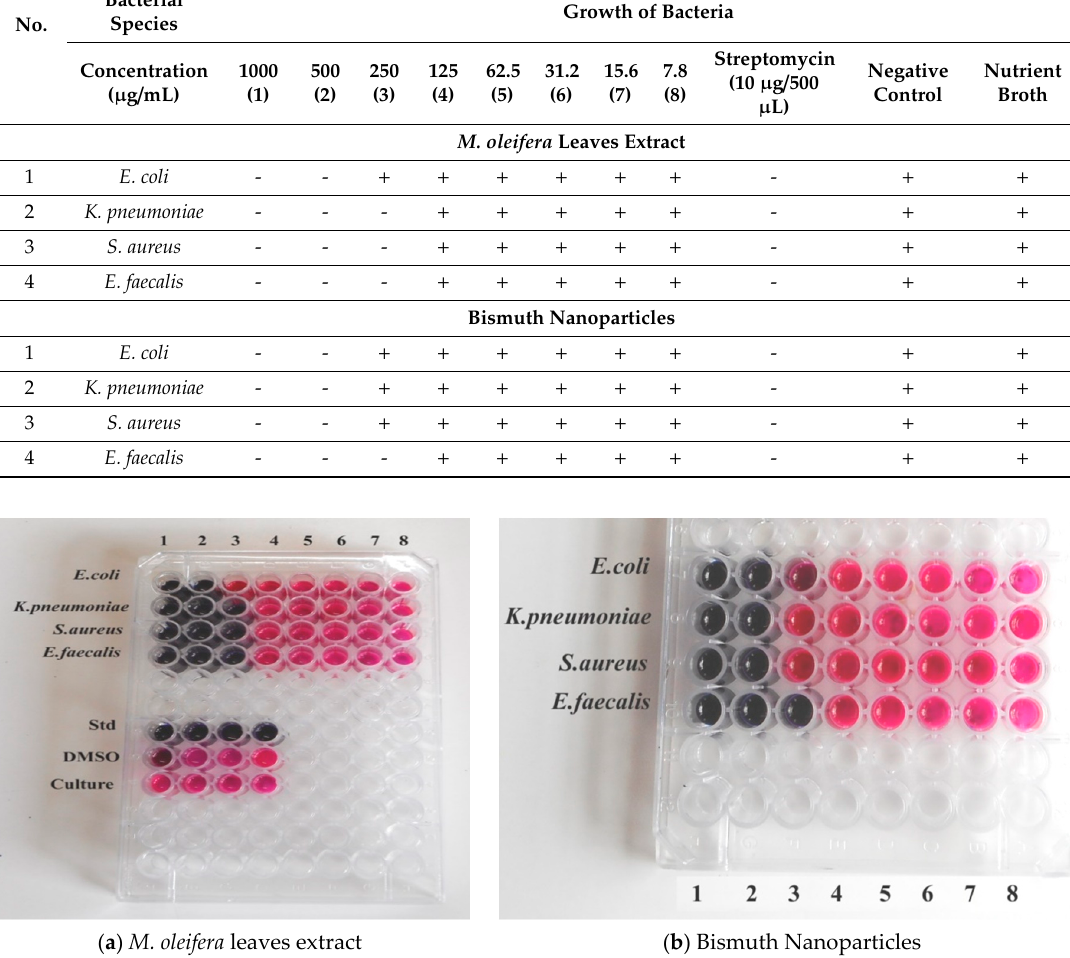
Figure 9. Resazurin microtiter assay plates for the antibacterial activity of M. oleifera leaves extract and the